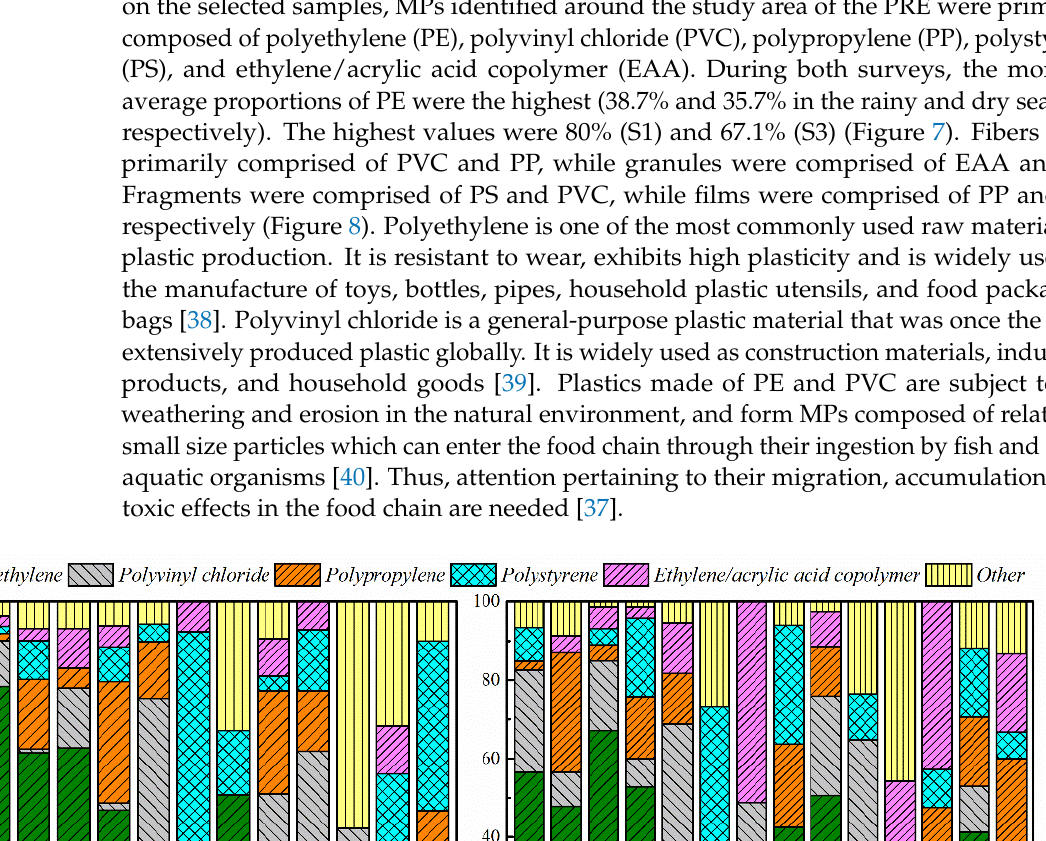
Figure 6. Principal component analysis (PCA) plot for MPs: ( a –Rain season, b –Dry season).